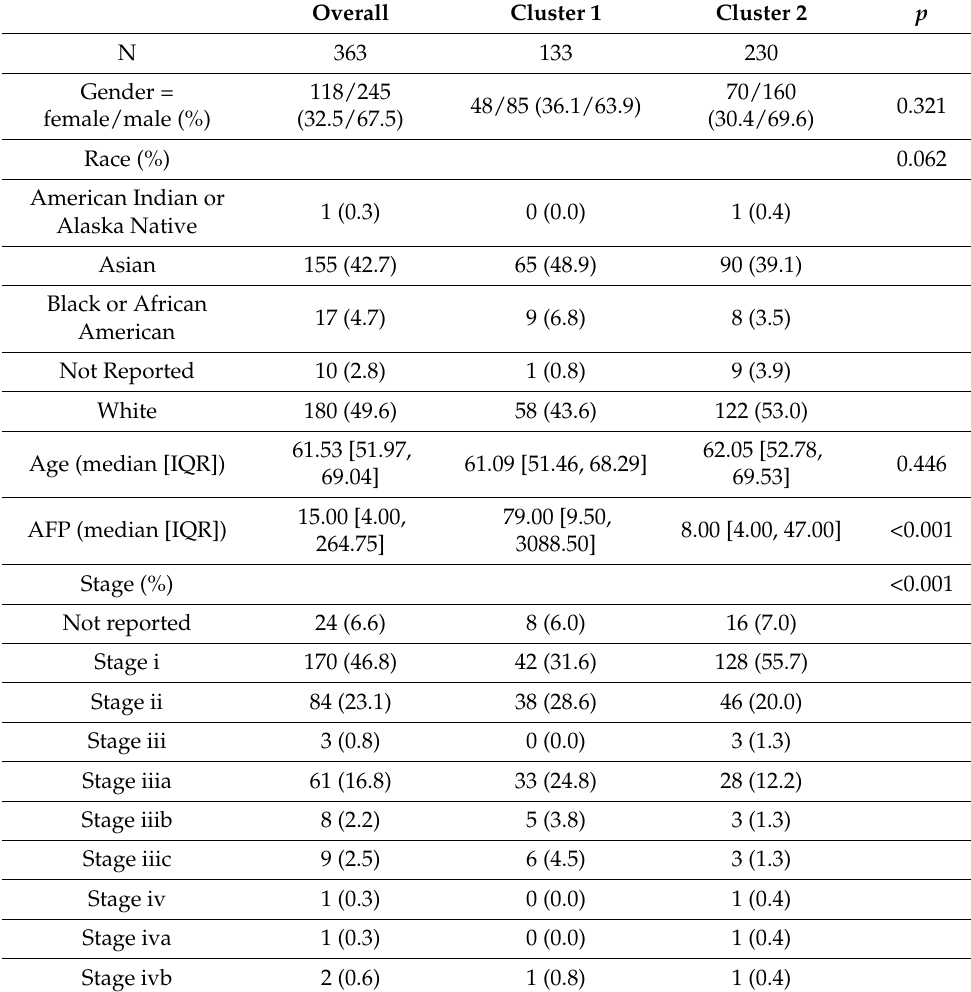
Table 1. Clinical variables of the two clusters in the TCGA-LIHC datasets. Overall Cluster 1 Cluster 2 p N 363